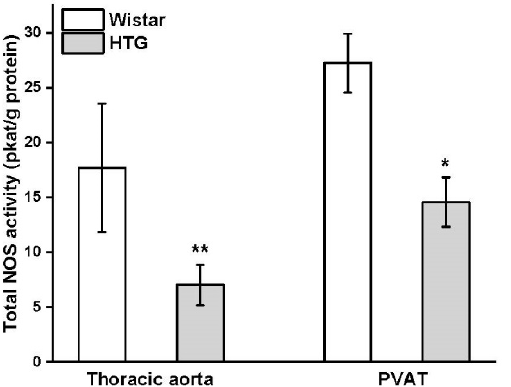
Figure 6. Total nitric oxide synthase (NOS) activity in the arterial wall of the thoracic aorta and perivascular tissue (PVAT) in Wistar rats (n = 7) and hypertriglyceridemic rats (HTG, n = 8). The results are presented as the mean ± S.E.M, and differences between groups were analyzed by one-way ANOVA with the Bonferroni post hoc test. * p < 0.05; ** p < 0.01 vs. HTG.